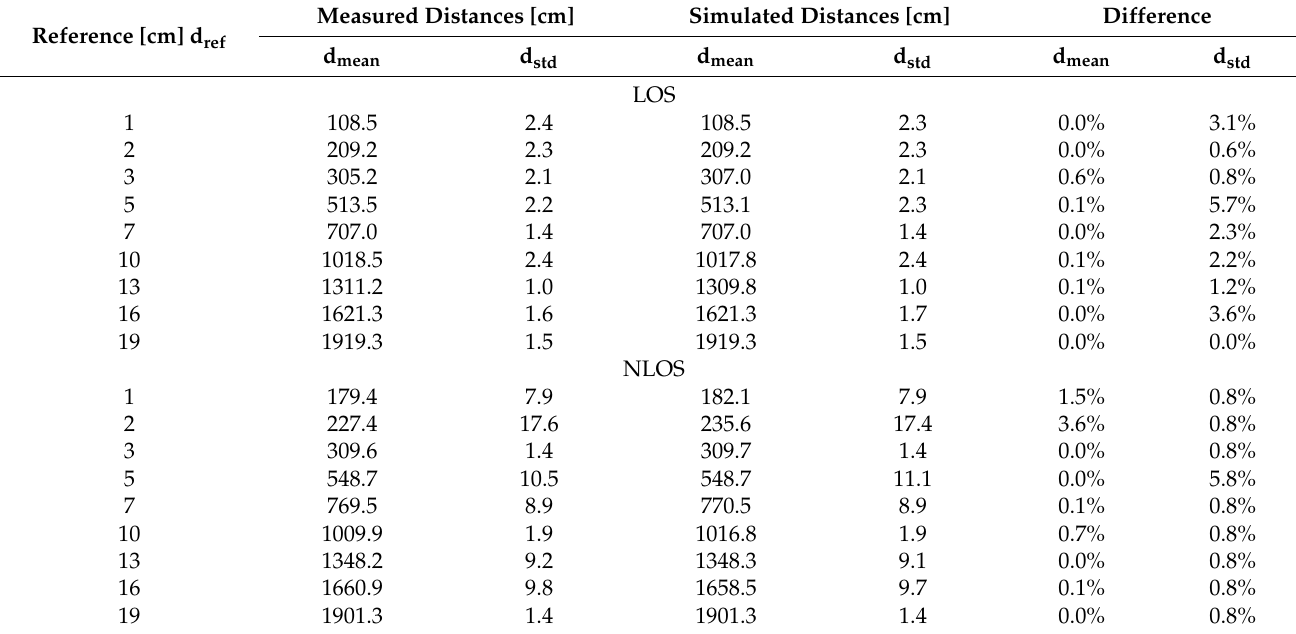
Table 6. Comparison of real data with simulated